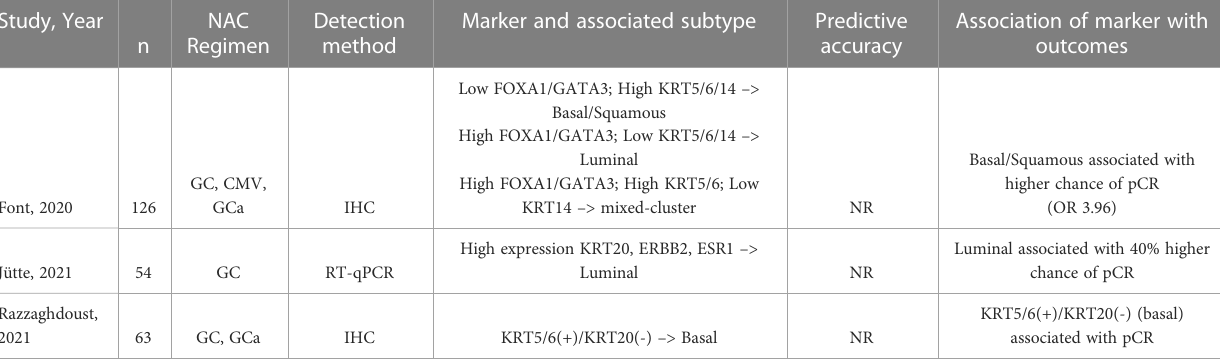
TABLE 3 RNA and tissue based biomarkers of bladder cancer subtype.